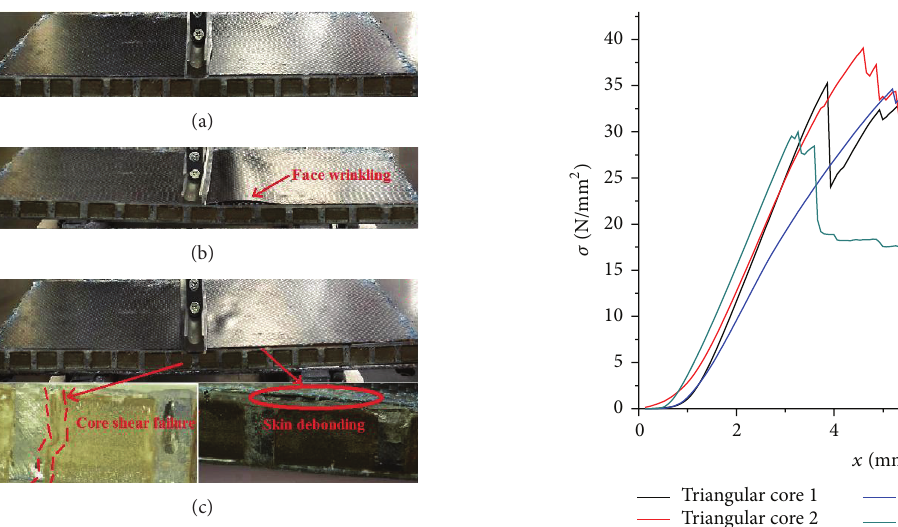
Figure 12: Stress-strain curve of sandwich